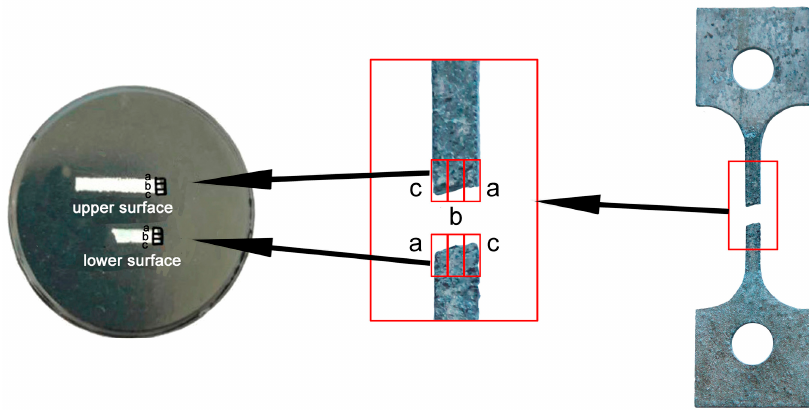
Figure 9. Schematic diagram of the position selected for microstructure observation.